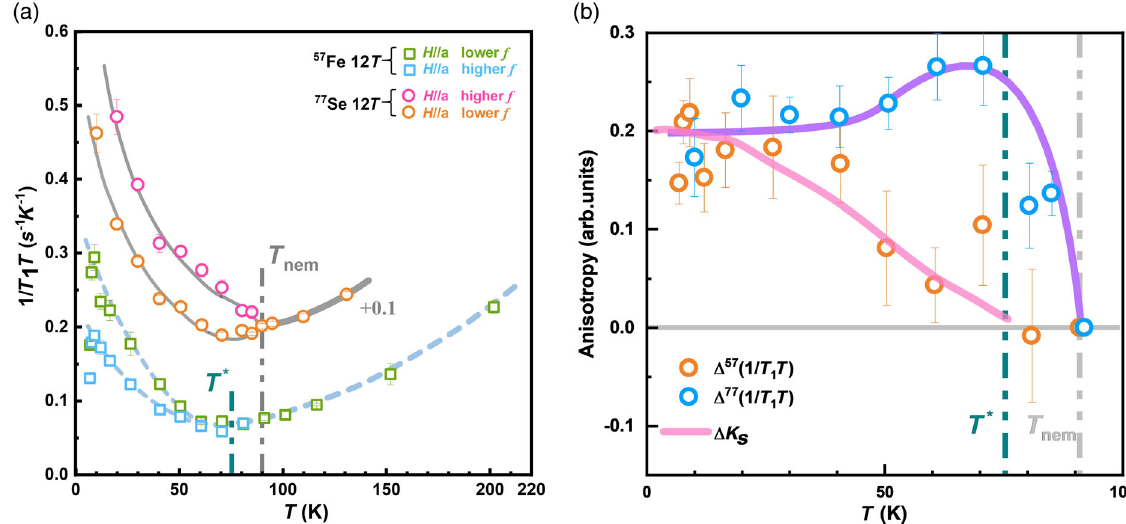
FIG. 4. Anisotropic nuclear spin-lattice relaxation in the nematic state: Temperature-dependent anisotropy in the spin-lattice relaxation rate divided by T . (a) Nuclear spin-lattice relaxation rate divided by T versus the temperature on the 57 Fe and 77 Se sites with H k a . Note that 1 =T 1 T of 77 Se in different domains are marked as open magenta and orange circles. The 1 =T 1 T of 57 Fe in different domains are marked as open green and blue squares. In order to compare with 57 Fe and 77 Se, the magnitudes of the 1 =T 1 T for 77 Se are shifted up by 0.1. Interestingly, the splitting of 1 =T 1 T for 57 Fe and 77 Se starts from different temperatures. (b) The temperature-dependent anisotropy in the 1 =T 1 T is defined as Δ 1 =T 1 T ¼ ½ð 1 =T 1 T j H show distinct temperature evolution below T below T (cid:3) , which is scaled with Δ s ð T Þ . In stark contrast to Δ 57 1 =T 1 T , Δ 77 1 =T 1 T shows a rapid increase immediately below T then follows a broad peak around 65 K. Finally, Δ 77 1 =T 1 T becomes saturated with temperature below 50 K. As discussed in the main text, such a difference between 57 Fe and 77 Se is related to the detailed information on both A hf ð q Þ and χ 00 ð q; ω Þ (see Sec. S8 in the Supplemental Material